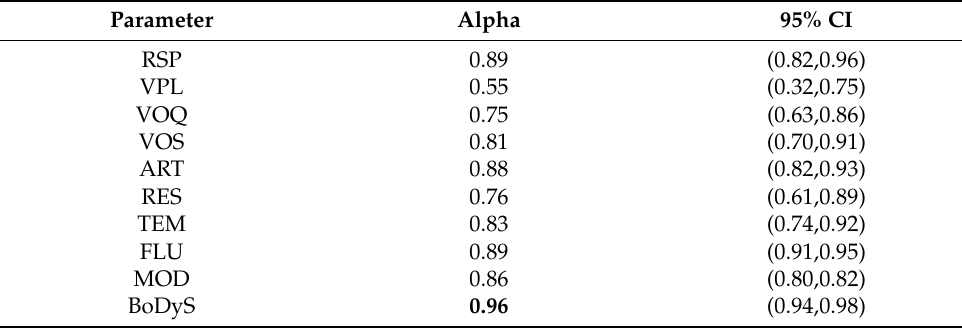
Table A2. Reliability of BoDyS ratings (Krippendorff’s alpha, ordinal scale, two independent